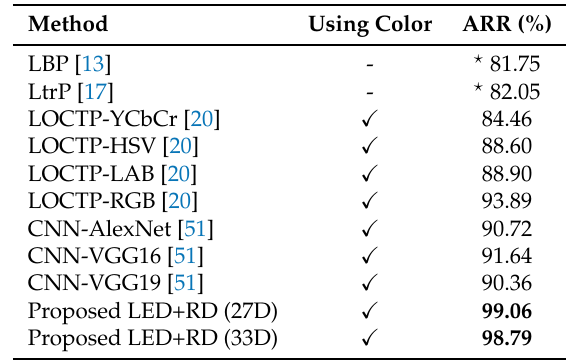
Table 5. Average retrieval rate (ARR) on CBT-2800 database by the proposed method compared to the state-of-the-art methods.